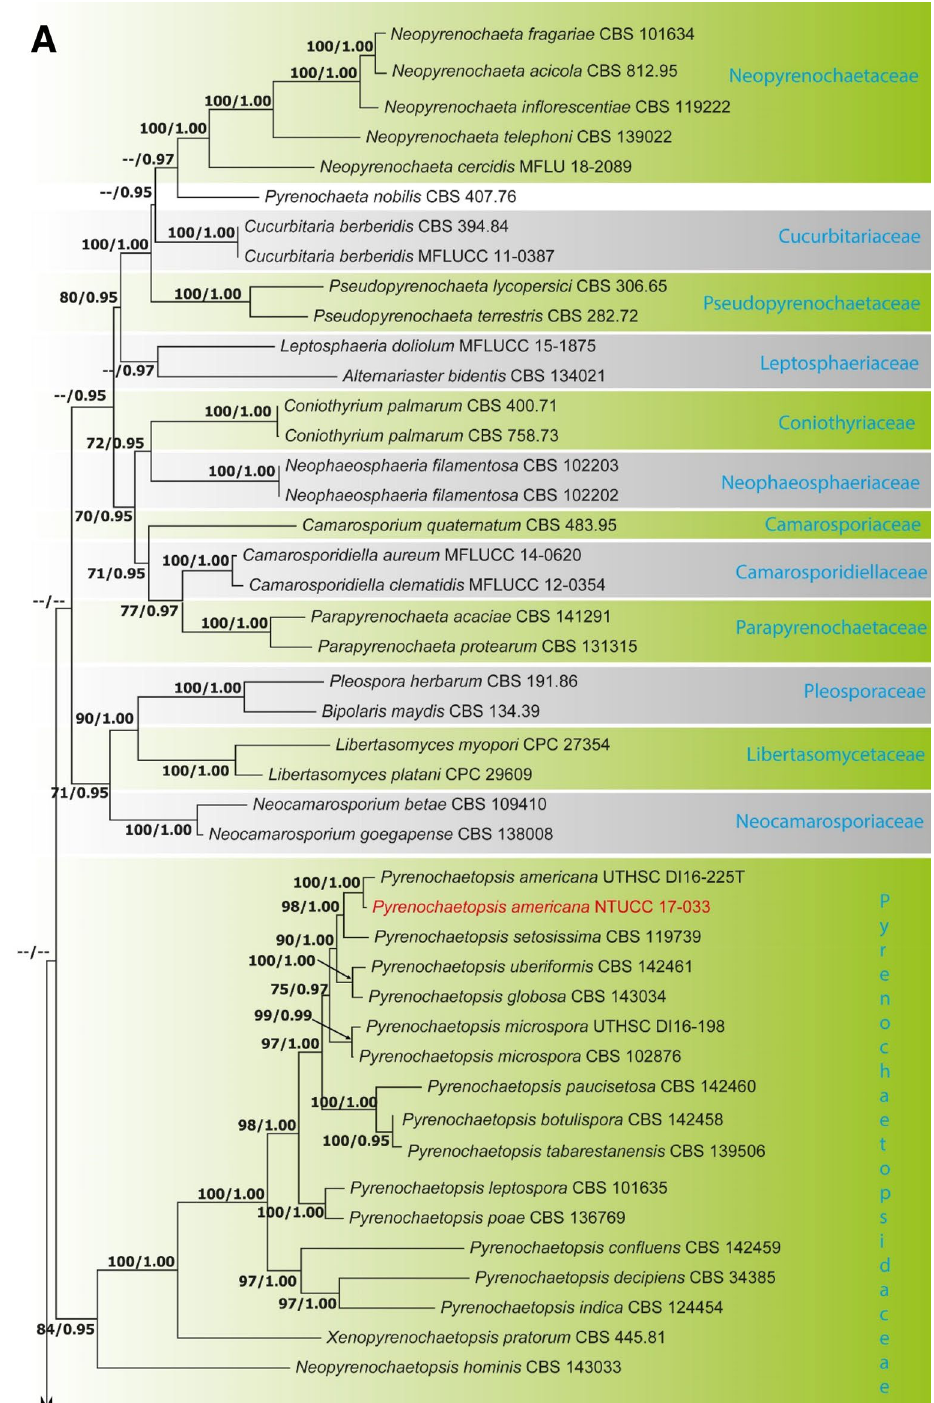
Figure 1. ( A ) Part one of the phylogenetic tree based on the concatenated alignment of six molecular markers (ITS, LSU, SSU, rpb 2, tef 1 and tub 2) evaluated using RAxML. The new isolates are shown in red. ML bootstrap values (MLBS) ≥ 70% and Bayesian posterior probabilities (PP) ≥ 0.95 are presented at the nodes. The scale bar indicates the number of estimated substitutions per site. Hysterium rhizophorae (PUFD43) was used as an outgroup for rooting the tree. ( B ) Part two, ( C ) Part three, ( D ) Part four, ( E ) Part five of the phylogenetic tree based on the concatenated alignment of six molecular markers (ITS, LSU, SSU, rpb 2, tef 1 and tub 2) evaluated using